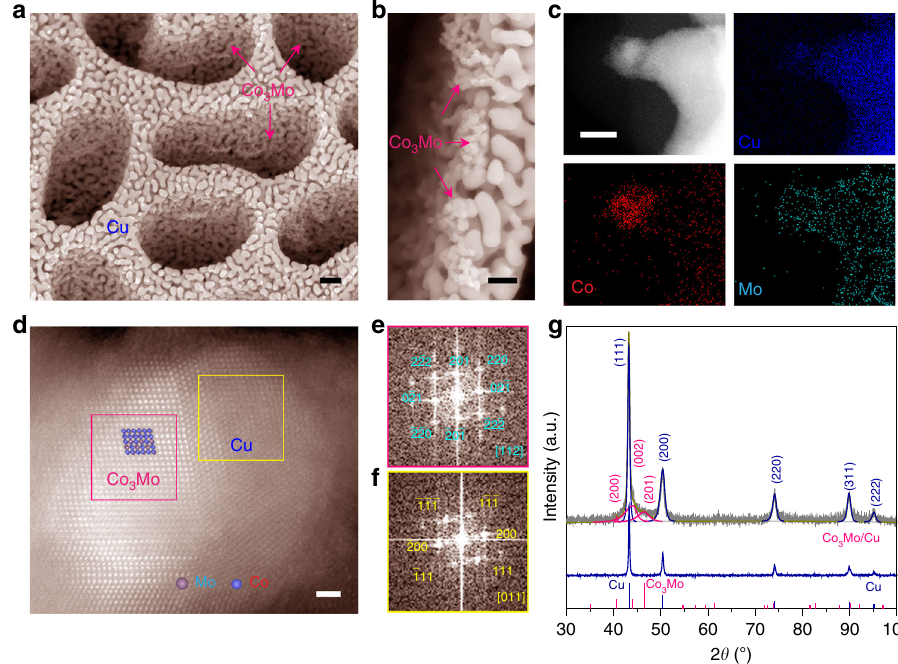
Fig. 1 Microstructures and chemical properties. a Typical cross-sectional SEM image of Co 3 Mo/Cu electrode prepared by chemically dealloying Cu 8 Co 3 Mo 1 Al 88 alloy precursor, displaying a three-dimensional bicontinuous and bimodal nanoporous architecture. Scale bar, 200 nm. b High-resolution cross-sectional SEM image of Co 3 Mo/Cu electrodes with a number of intermetallic Co 3 Mo nanoparticles in-situ integrated on Cu ligaments. Scale bar, 100 nm. c STEM image and the corresponding STEM-EDS elemental mappings of Cu, Co and Mo, demonstrating the Co 3 Mo nanoparticles grown on Cu ligaments. Scale bar, 10 nm. d Atomic resolution HAADF-STEM image of intermetallic Co 3 Mo nanoparticles grown on Cu ligament with a coherent interface structure. Inset: atomic structure of intermetallic Co 3 Mo. Scale bar, 1 nm. e , f FFT patterns of Co 3 Mo ( e ) and Cu ( f ) in the selected areas in ( d ). g XRD patterns of nanoporous Co 3 Mo/Cu hybrid electrode and bare nanoporous Cu electrode. The line patterns show reference cards 04-0836 and 29-0488 for Cu and Co 3 Mo phases according to JCPDS,